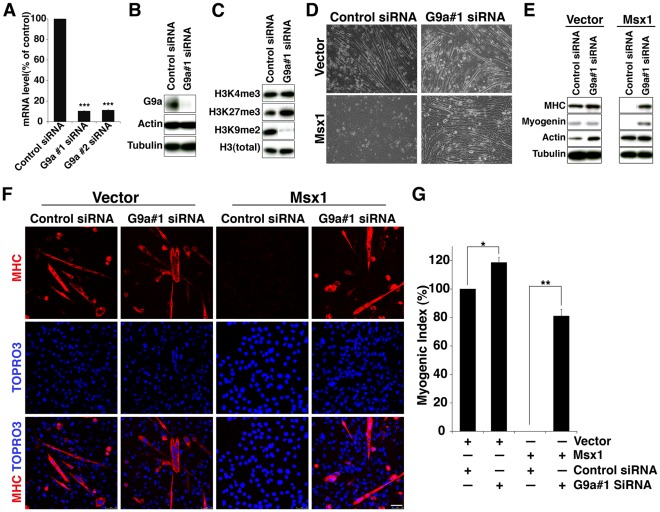
Association of Msx1 with G9a is required for regulation of myoblast differentiation.(A) Quantitative PCR to determine the level of G9a mRNA following knock-down by siRNA, mRNAs were prepared 48 hours after transfection with the indicated siRNA. (B) Western blot assay for efficiency of G9a knock-down, C2C12 cells were transfected with the indicated siRNA, extracts prepared 72 hours after transfection and analyzed by western blotting for the indicated proteins. (C) Western blot assay for histone marks. C2C12 cells were transfected with the indicated siRNA, extracts prepared 72 hours after transfection and analyzed by western blotting for the indicated histone marks. (D) Differentiation assay of C2C12 cells expressing (+) or lacking (-) Msx1 along with the control or G9a siRNA. Micrographs of C2C12 cells show the absence of myotubes in Msx1-expressing cells but not in cells also expressing the G9a siRNA on Day 3 after differentiation. (E) Western blots analyses of markers of terminal muscle differentiation, MHC and Myogenin on Day 3 after differentiation. (F) Immunofluorescence assays done on Day 2 after differentiation as detected using antibody for MHC and the nuclear marker TOPRO3. The scale bars represent 50 µm. (G) Quantitative analyses of myogenic index on Day 2 after differentiation. The percentage of MHC+ cells in vector cells with control siRNA was given a value of 100%. In A and G, the * indicate the following: ***P<0.0001, **P<0.001, *P<0.01.